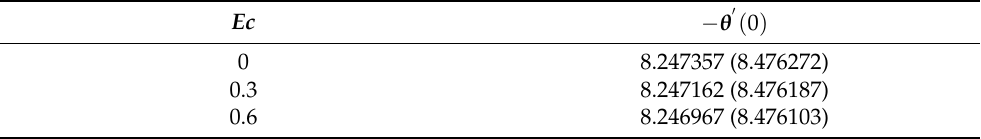
Table 4. The results of the Eckert number Ec when φ 1 = 0.01, φ 2 = 0.03, S = 2, ω = 0.01, M = Rd = 0.1, λ = − 1, and Pr =